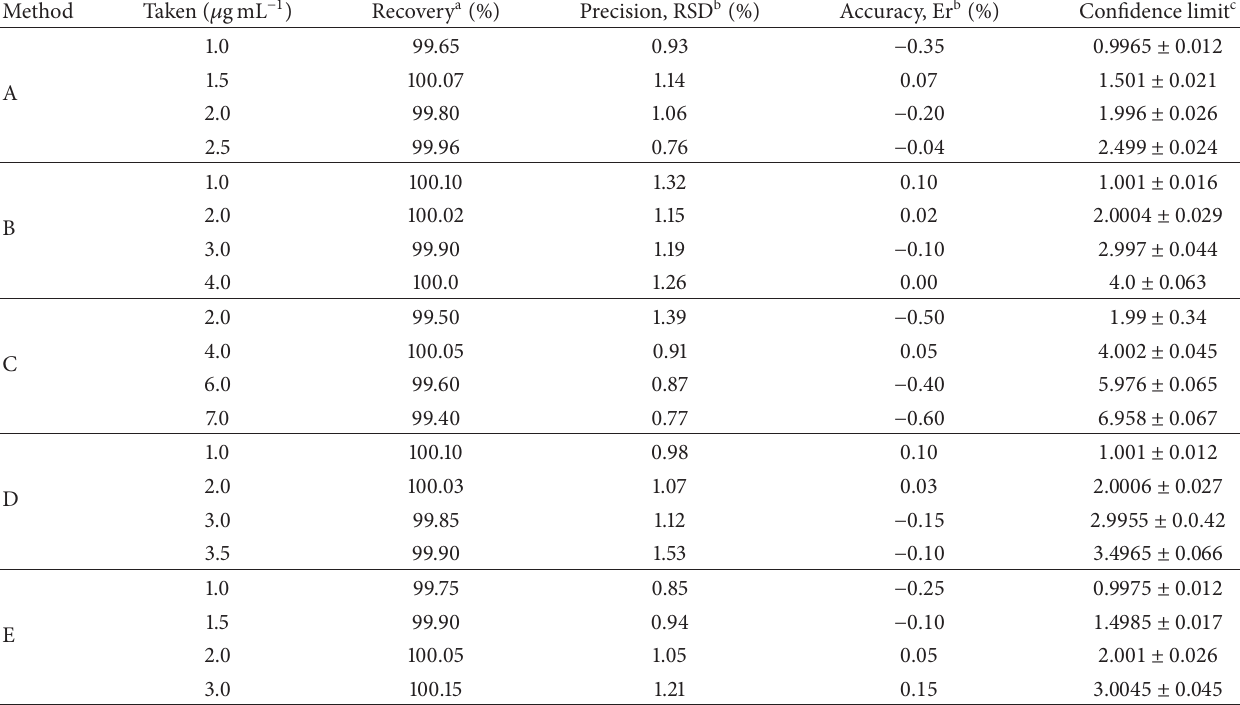
Table 3: Evaluation of intraday precision and accuracy of PZT using the proposed methods.